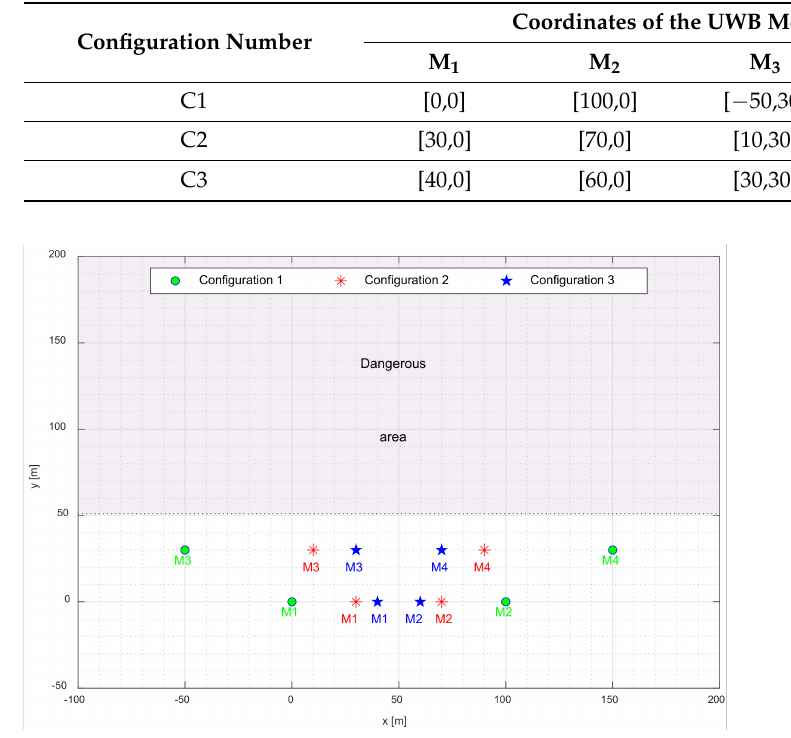
Figure 9. Locations of the UWB stationary modules for different system